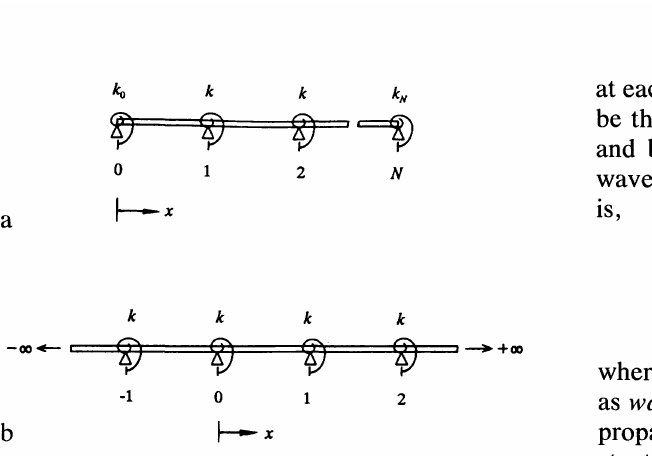
FIGURE 1 Multi-span beams with elastic rotational spring at each support: (a) finite length; (b) infinite